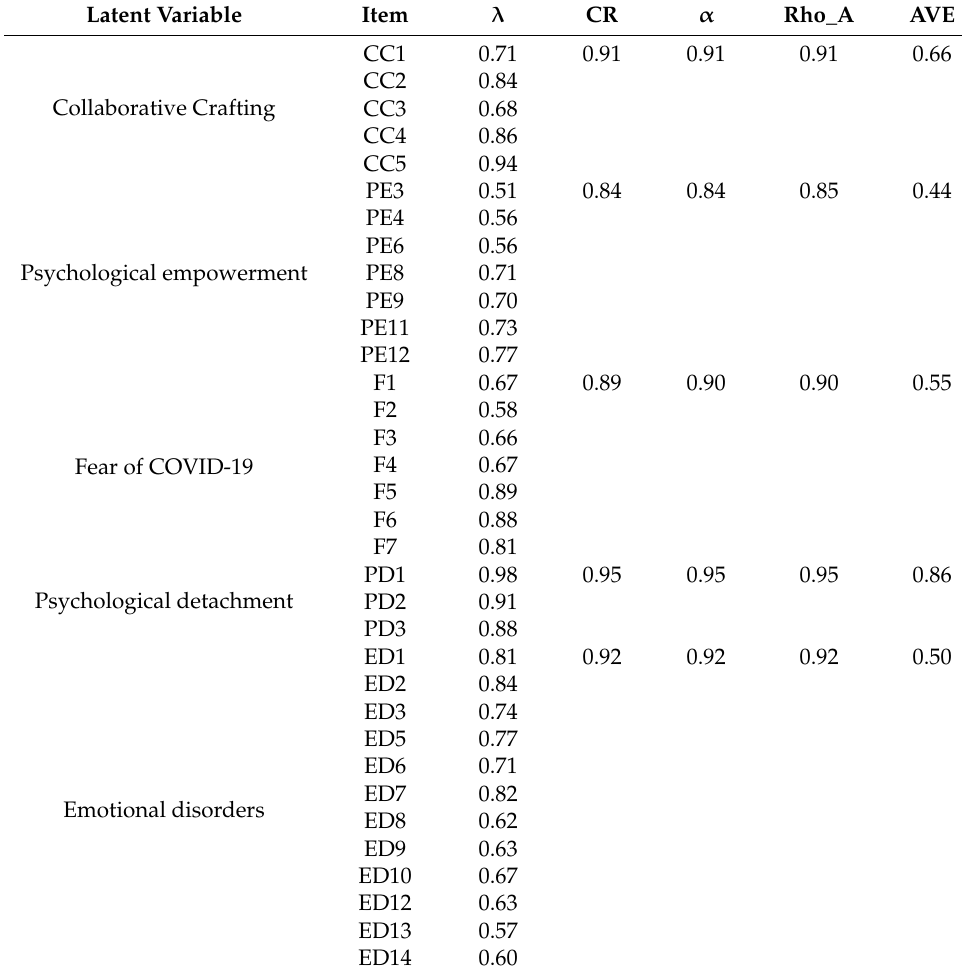
Table 3. Measurement model: loads, construct reliability, and convergent